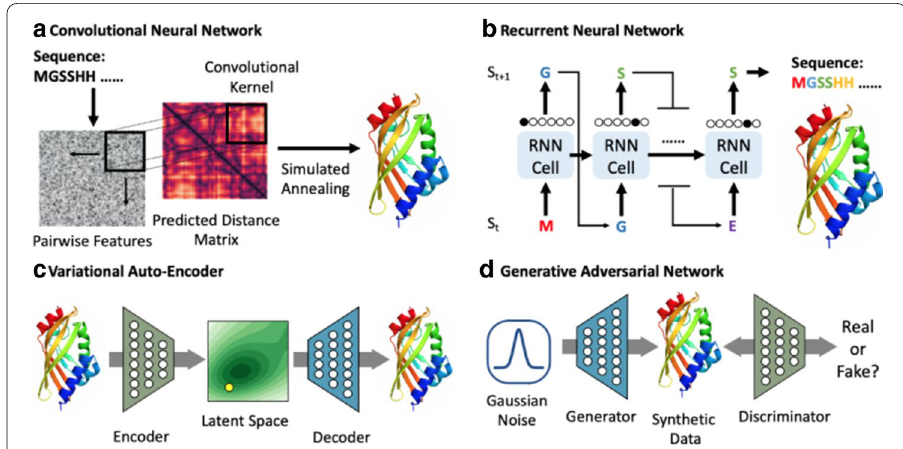
Fig. 15 Illustrations of how different Neural Network architectures have been applied to Protein Structural Modeling (Image taken from Gao et al.